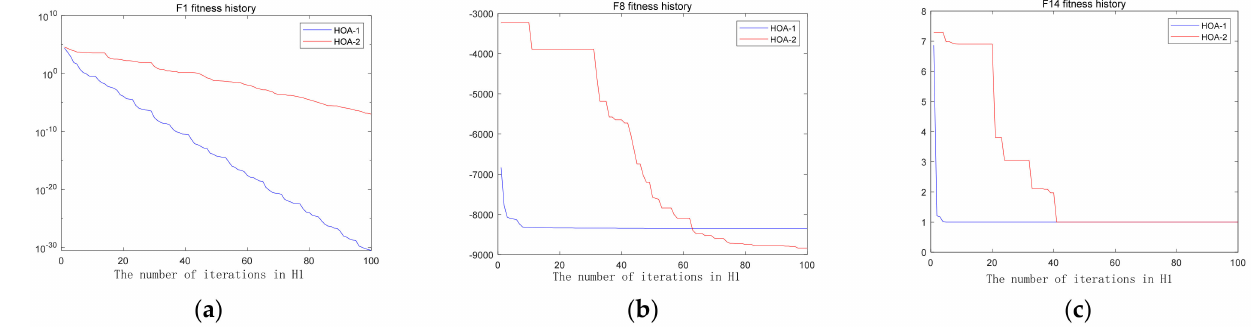
Figure 5. The history fitness curves solved by HOA-1 and HOA-2 for ( a ) F1; ( b ) F8; ( c ) F14.